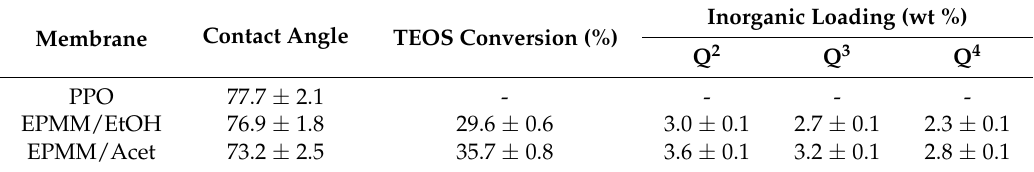
Table 5. Contact angle, conversions of TEOS, and inorganic loadings in the membranes. Membrane Contact Angle TEOS Conversion